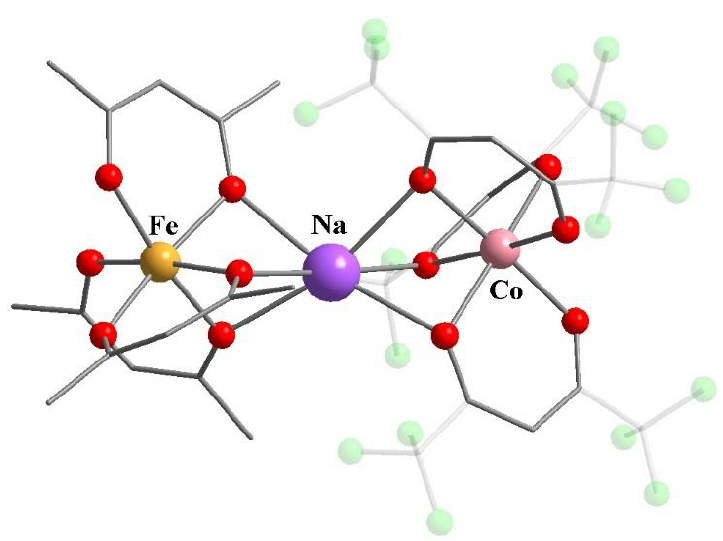
Figure 5. Molecular structure of 13 [67]. Hydrogen atoms have been omitted, CF 3 groups of hfac are transparent for clarity. The cif has been retrieved from CCDC. CCDC number is 1964370.